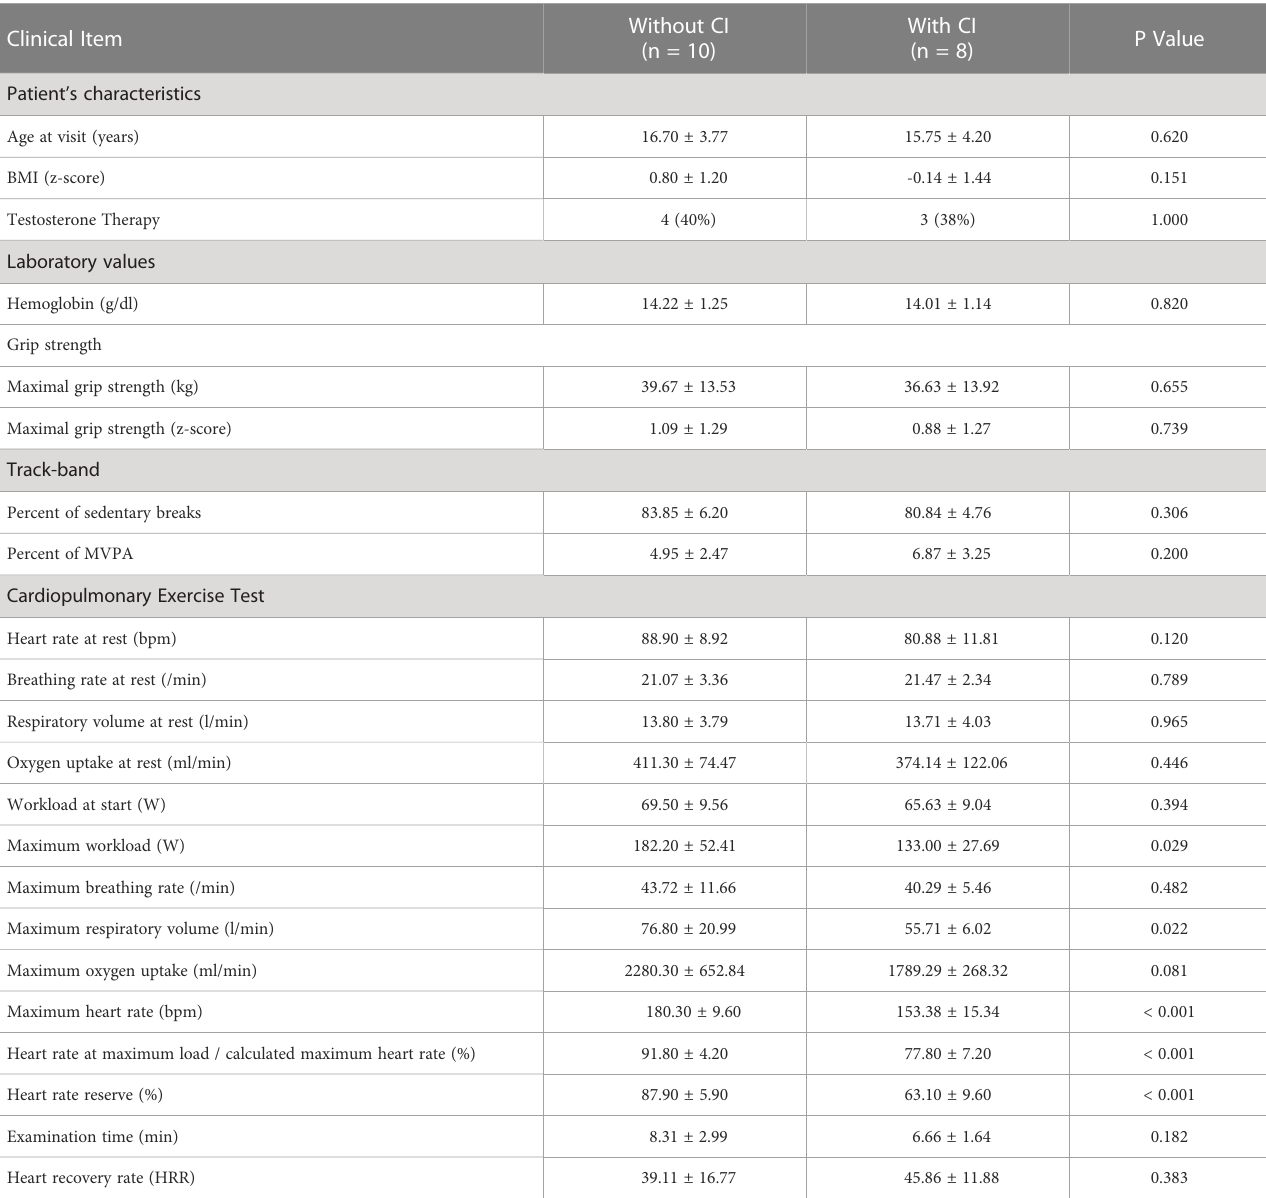
TABLE 4 Comparative analysis between participants without and with Chronotropic insuf fi ciency